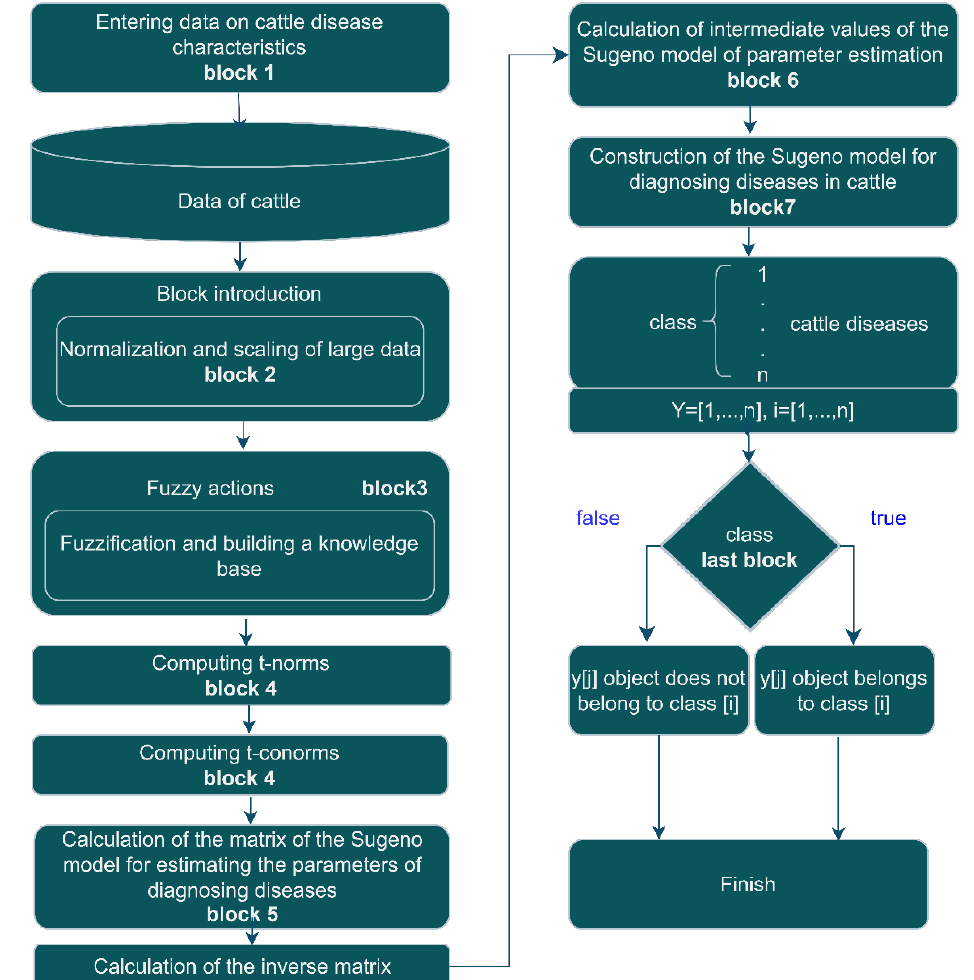
Figure 2. Functional scheme for diagnosing diseases in cattle. In the first block, trait data for cattle diseases are entered, which are divided into classes. In the second block, data with signs of cattle diseases are normalized and